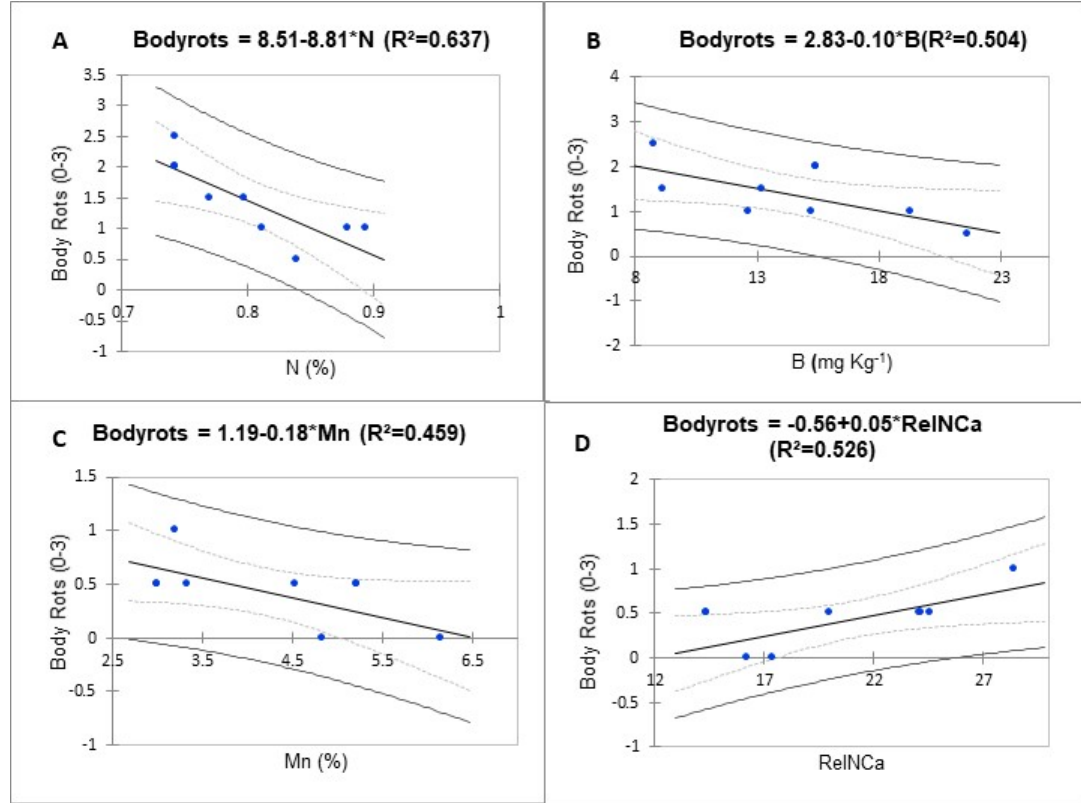
Figure 6. Minerals content (N, B, Mn, and N/Ca) and their relation to body rot: ( A , B ) BV farm (DM-30, ST= 3 weeks); ( C , D ) LE farm (DM-30, ST = 0 weeks).